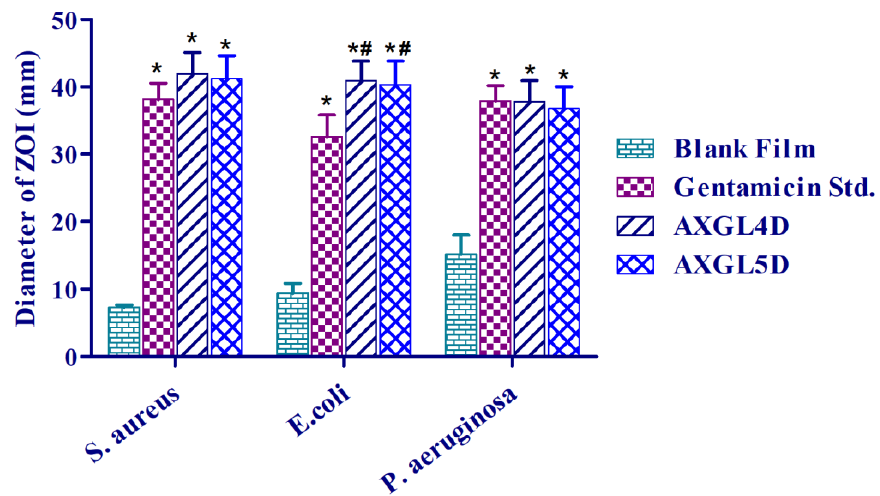
Figure 6. Antibacterial activity of AX-GL films. The asterisks (*) and (#) signs indicate a significant difference (* p < 0.05) from the blank AX-GL film and standard GM, respectively.